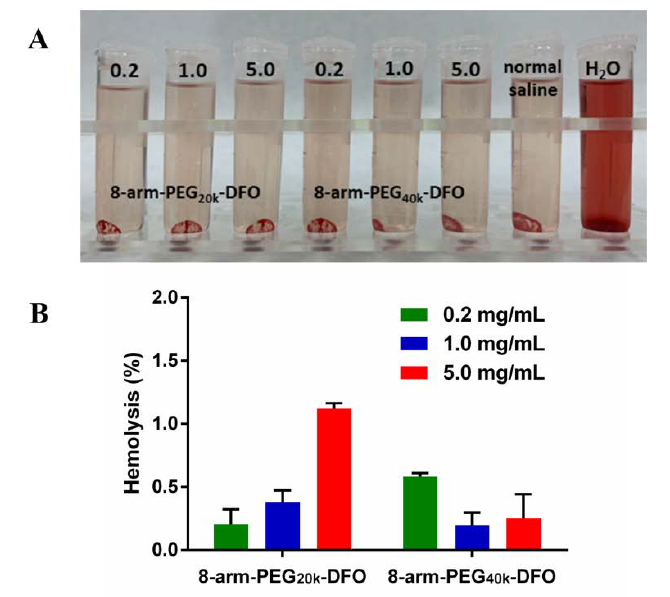
Figure 3. The hemolysis test of the 8-arm-PEG-DFO conjugates. ( A ) The visual appearance of the 8-arm-PEG-DFO conjugates with di ff erent contents in red blood cell (RBC) suspension for hemolysis test; ( B ) The hemolysis (%) of the 8-arm-PEG-DFO conjugates with di ff erent contents in RBC suspension, even when the concentration reached 5 mg / mL, the conjugates did not show significant hemolysis.